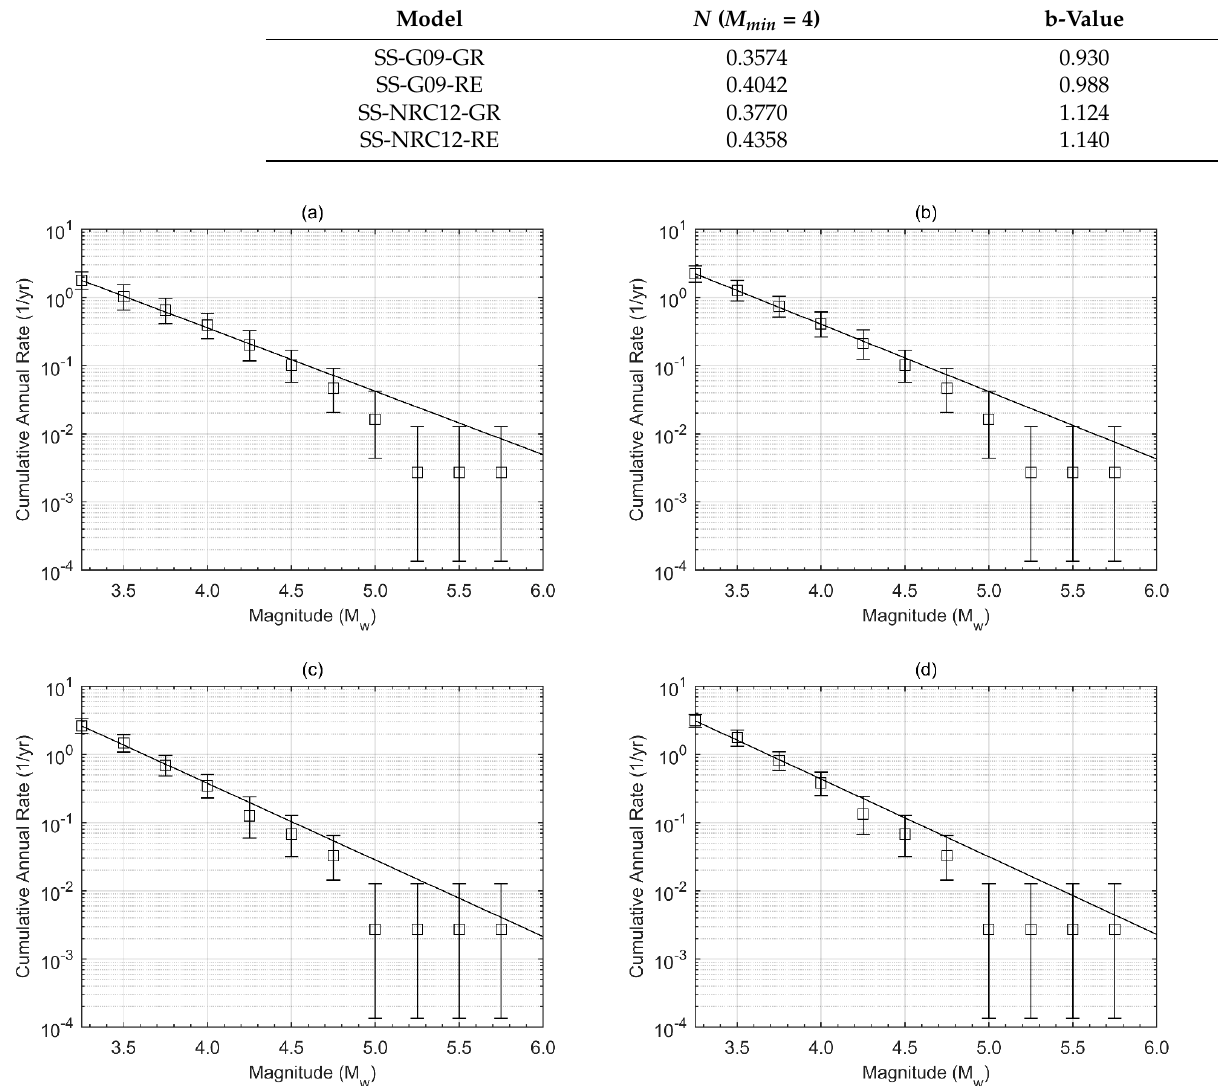
Figure 4. Magnitude recurrence relations versus cumulative annual rates for ( a ) SS-G09-GR, ( b ) SS- G09-RE, ( c ) SS-NRC12-GR, and ( d ) SS-NRC12-RE.